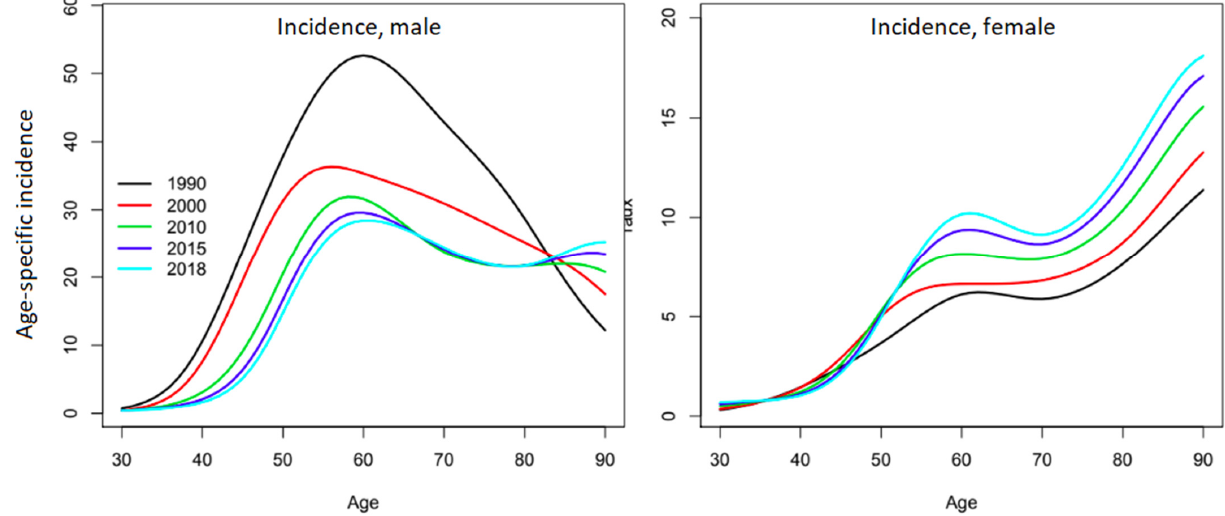
Figure 3. Evolution of age-specific incidence of oral cavity cancers for French men and women. Re- printed with permission from Defossez G, Le Guyader-Peyrou S, Uhry Z, Grosclaude P, Colonna M, Dantony E, et al. Estimations nationales de l’incidence et de la mortalité par cancer en France métropolitaine entre 1990 et 2018. Volume 1 – Tumeurs solides. Compléments par localisation tu-